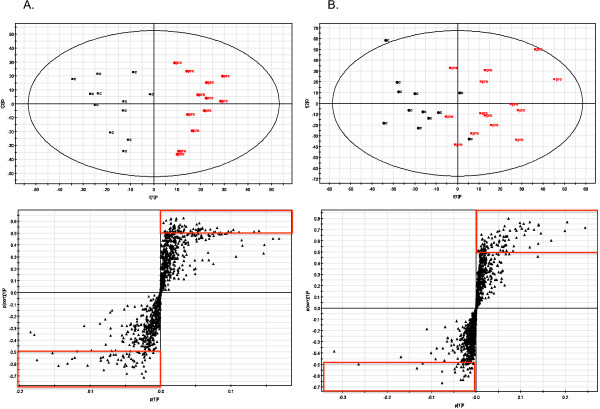
OPLS-DA models and representative scores plots from positive mode analysis (A) and negative mode analysis (B). Black markers in the OPLS model represent lean controls, red markers represent obese pre-operative subjects. Each triangle on the scores plot represents an ion that was detected. The red boxes show the ions that were screened for further analysis.